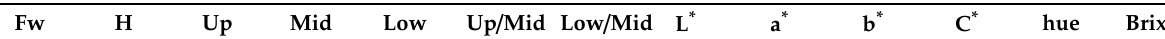
Table 1. Correlation of traits in the F 2 population.